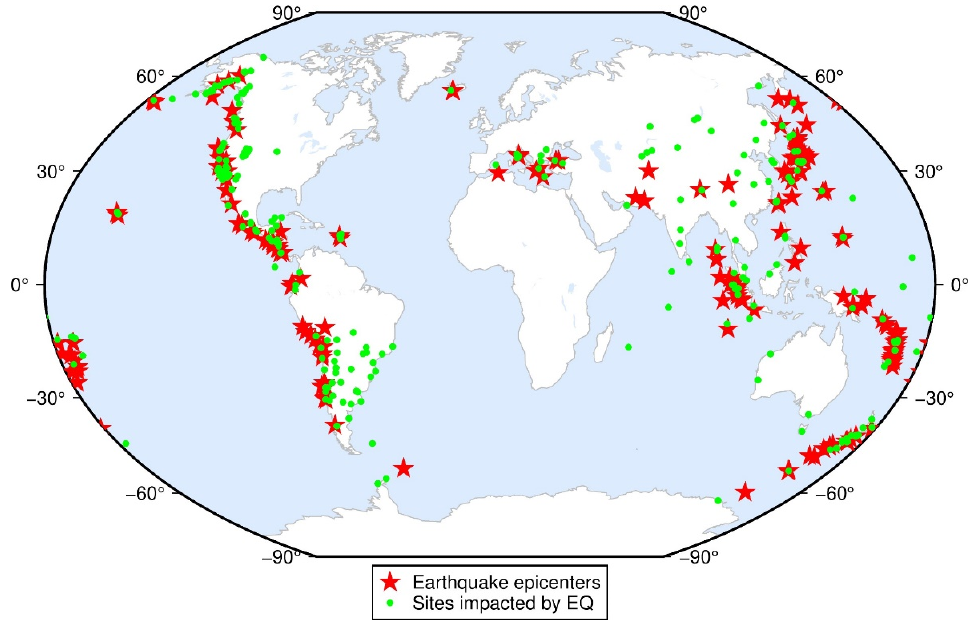
Figure 7. Distribution of earthquake epicenters and sites impacted by seismic deformation.